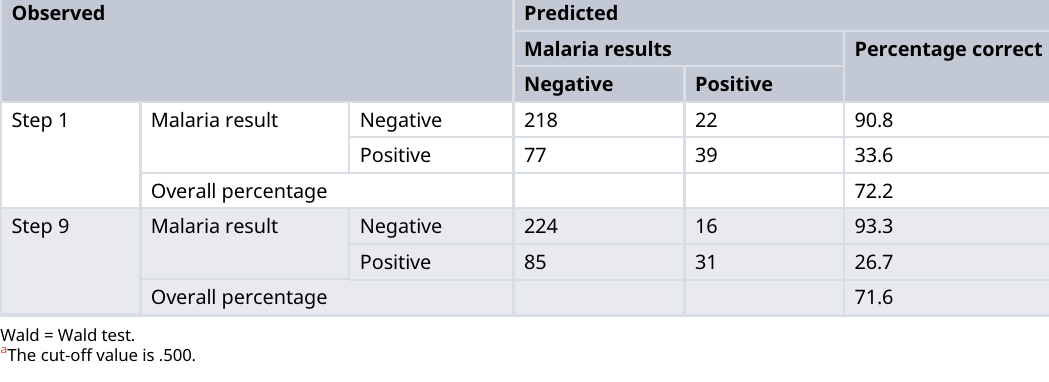
Table 3. Final backward stepwise (Wald) model classification table.